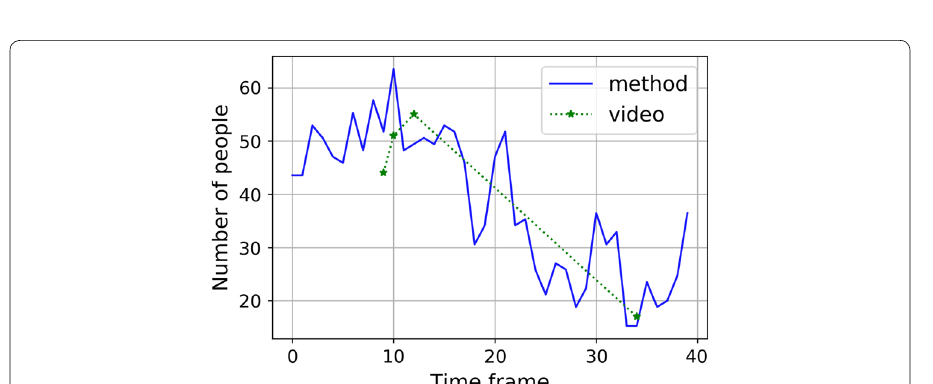
Fig. 17 Performances of our method w.r.t. video based counting in a 112.5 m 2 near the main stadium